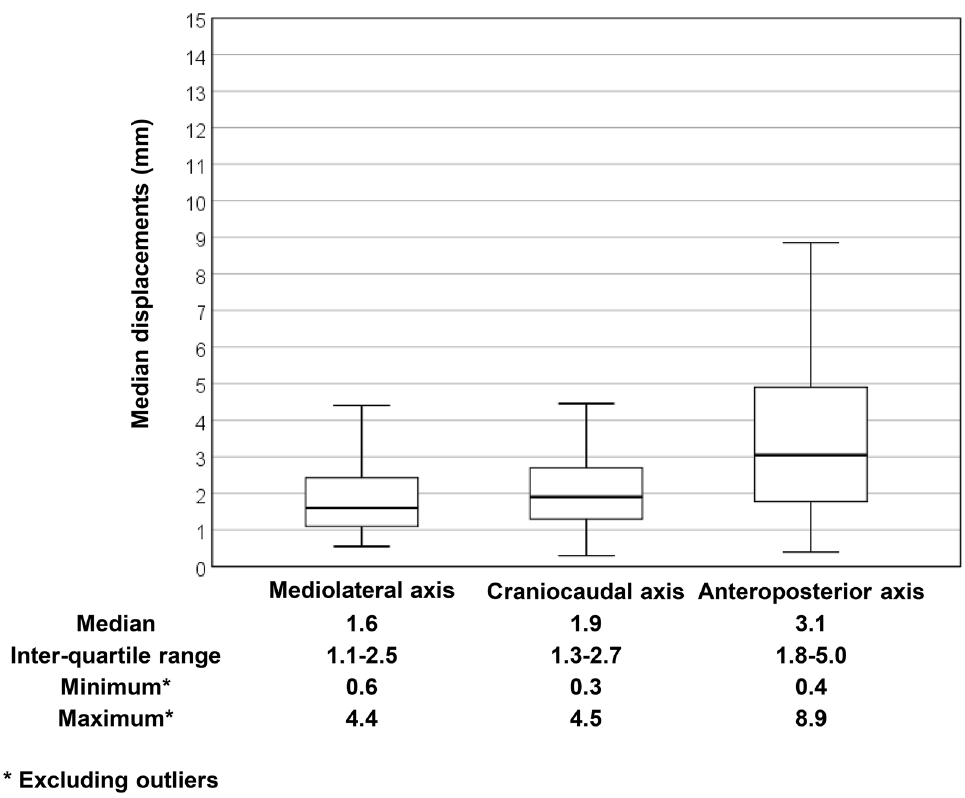
Figure 1. Distribution of median interfractional displacements in the three major axes. The top end and the bottom end of the error bar are the maximum and minimum value excluding outliers of the interfractional displacements of three axes, respectively. The outliers were defined as larger (smaller) values than the upper (lower) boundary, which were defined as 1.5 IQR above (below) 75th (25th) percentile. Figure created in